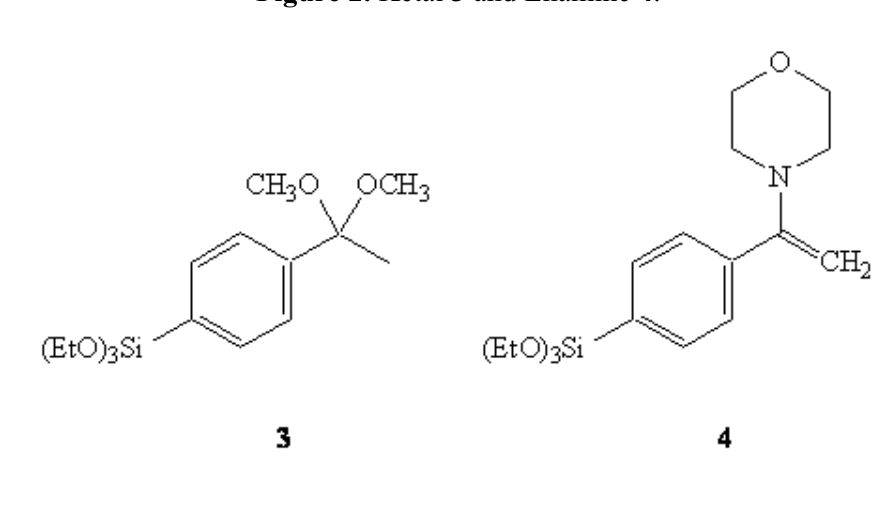
Figure 2. Ketal 3 and Enamine 4